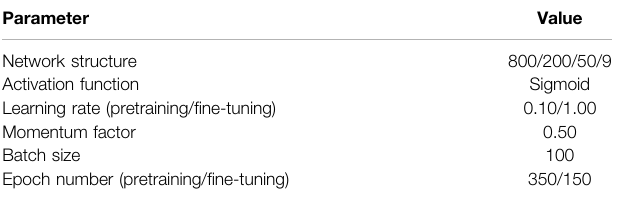
TABLE 3 | Parameters of deep belief network model.